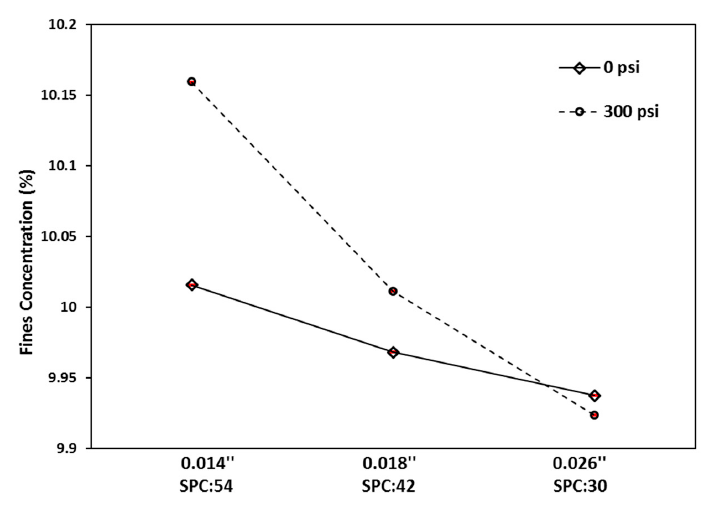
Figure 15. Effect of slot size and density on retained permeability at the near-coupon zone.